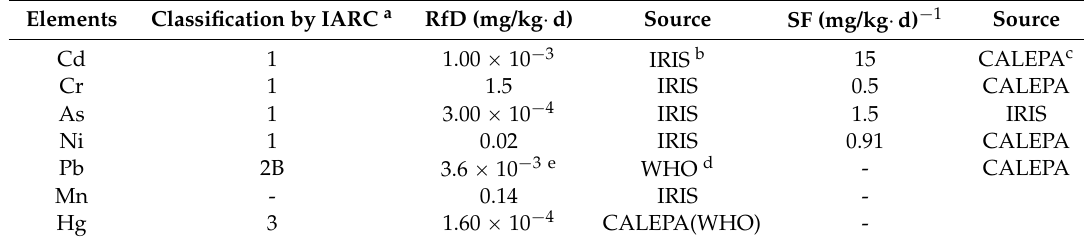
Table 2. Reference doses (RfD) and slope factors (SF) of seven heavy metals.